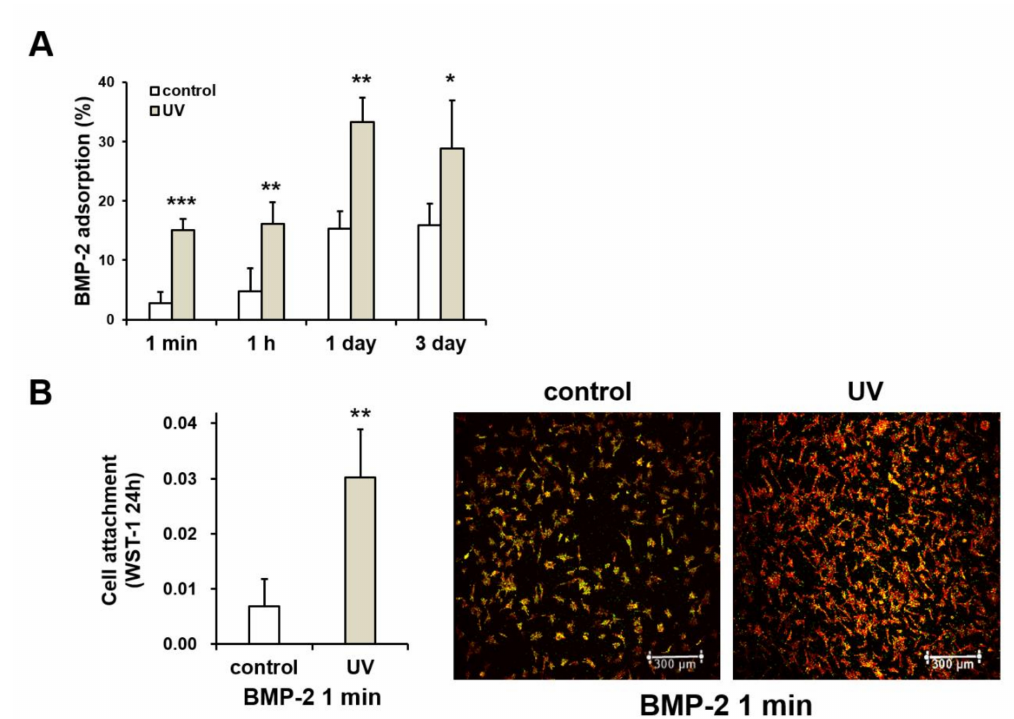
Figure 8. E ff ect of UV treatment on bone morphogenetic protein-2 (BMP-2) adsorption ability of titanium. ( A ) Adsorption rates (means ± standard deviation) of bovine plasma BMP-2 after 1 min, 1 h, 1 day, and 3 days of incubation on control and UV-treated (UV) surfaces ( n = 3). ( B ) Initial cellular attachment to titanium surfaces. A 1-min adsorption protocol was used. Rat bone marrow-derived osteoblasts attached to the control and UV-treated titanium disks were evaluated by WST-1 assay after 24 h of seeding. Fluorescence micrographs of osteoblasts cultured on control- and UV-treated titanium surfaces after 24 h of seeding. Representative images of cells stained with rhodamine-phalloidin for actin (red: cytoskeleton protein) and an antibody to vinculin (green: focal adhesion-related protein) are presented. Scale bar = 300 µ m. Each value represents the mean ± standard deviation from triplicate experiments ( n = 3). Asterisks indicate significant di ff erences (* p < 0.05, ** p < 0.01, *** p < 0.001, Welch’s t